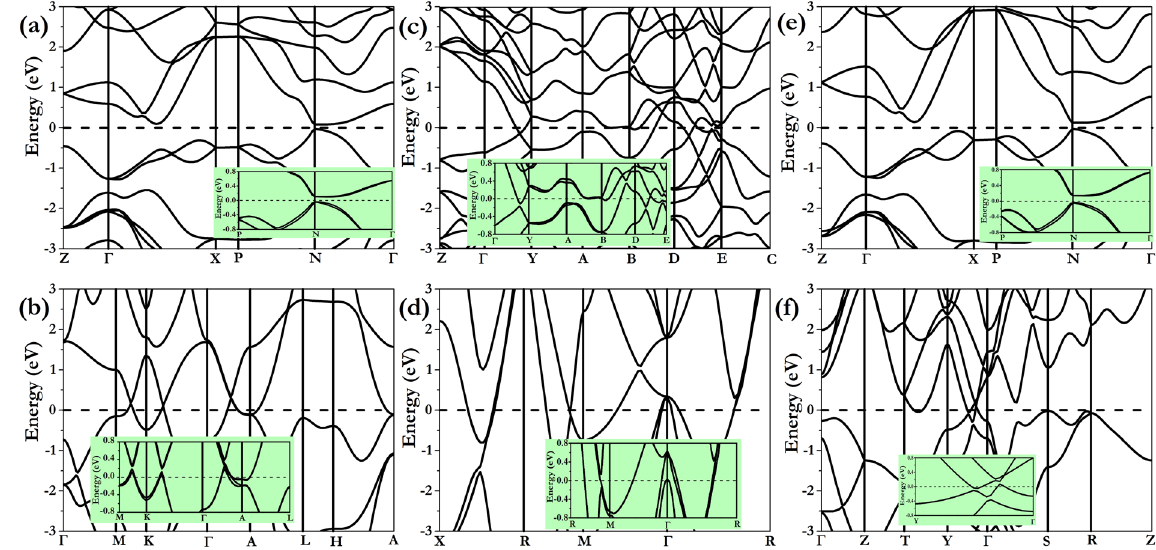
Figure 4. Calculated electronic band structures of NbAs and NbP at different pressures without spin–orbit coupling (SOC) while the insets including the SOC effect are enlarged along prominent direction. (a) I 4 1 md structure of NbAs at 0 GPa, (b) P -6m2 structure of NbAs at 30 GPa, (c) P 2 1 /c structure of NbAs at 50 GPa, (d) P m-3m structure of NbAs at 80 GPa, (e) I 4 1 md structure of NbP at 0 GPa, and (f) C mcm structure of NbP at 80 GPa.